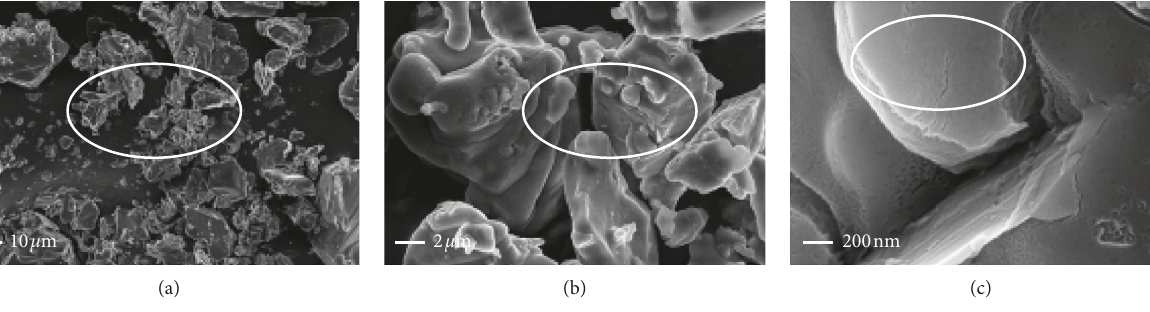
Figure 6: The images of KNO 3 (43.24%)/NaNO 3 (50.76%)/graphite (6.00%).